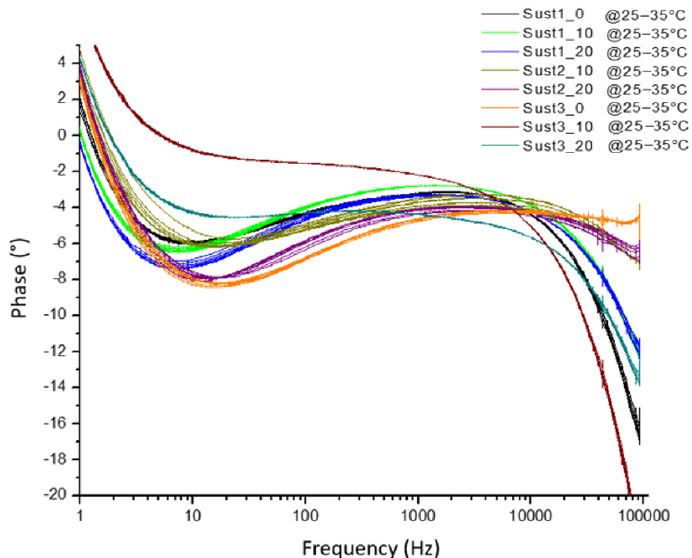
Figure 13. Amplitude frequency response as a function of the temperature for eight samples.